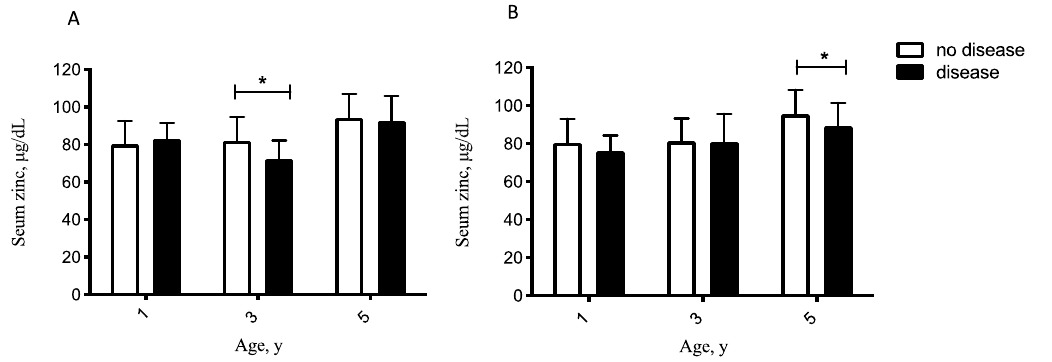
Figure 2. Comparing serum zinc concentration between children who have had pneumonia ( A ) and infectious enterocolitis ( B ) before the ages of 1, 3, and 5 years with those having never suffered from the above diseases. Values represent means ± SD. * means differ at that age, p < 0.05.